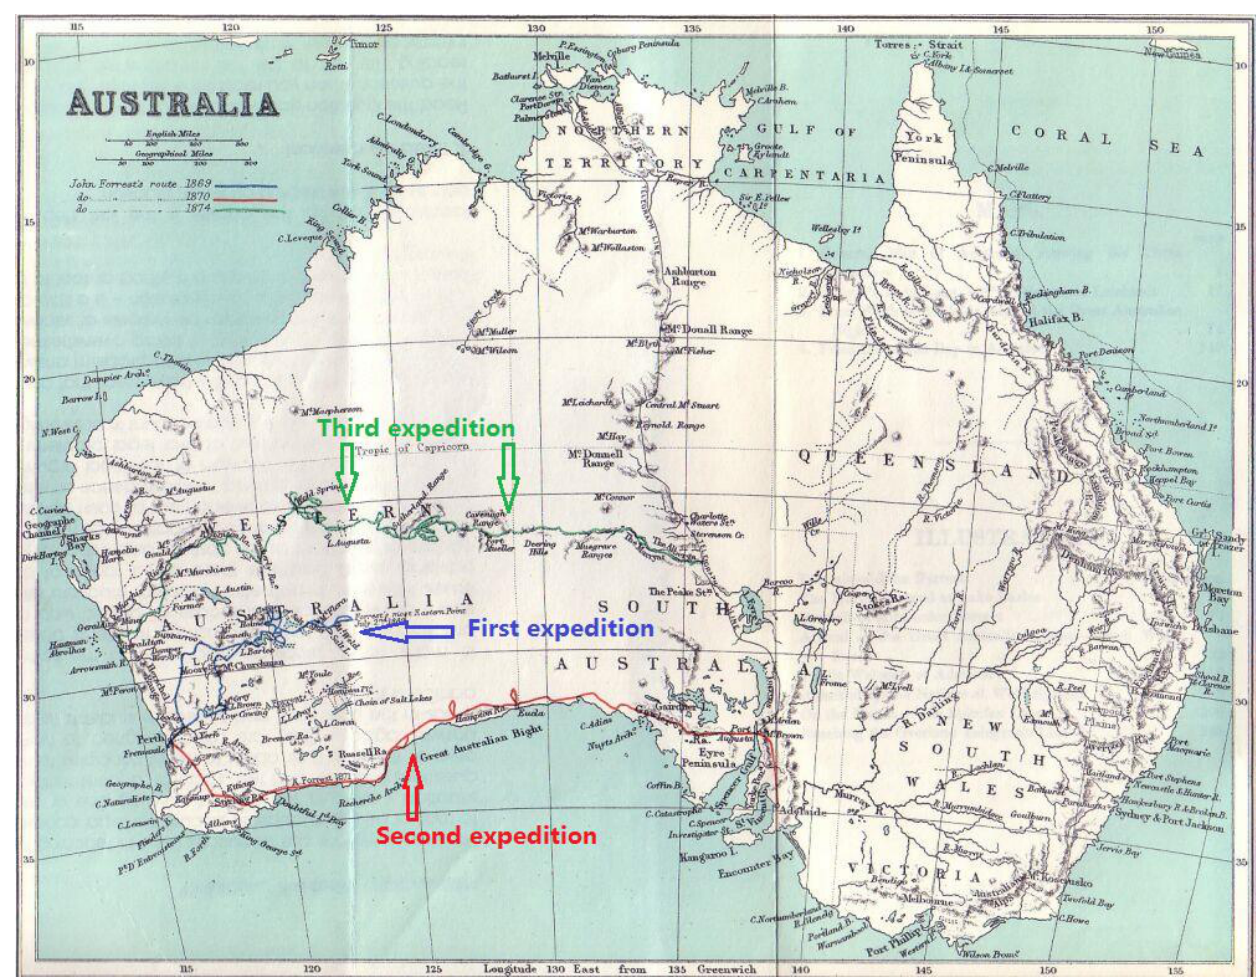
Figure 1. Text of the last day of the expedition, extracted from John Forrest ’s book “Explorations in Australia .”